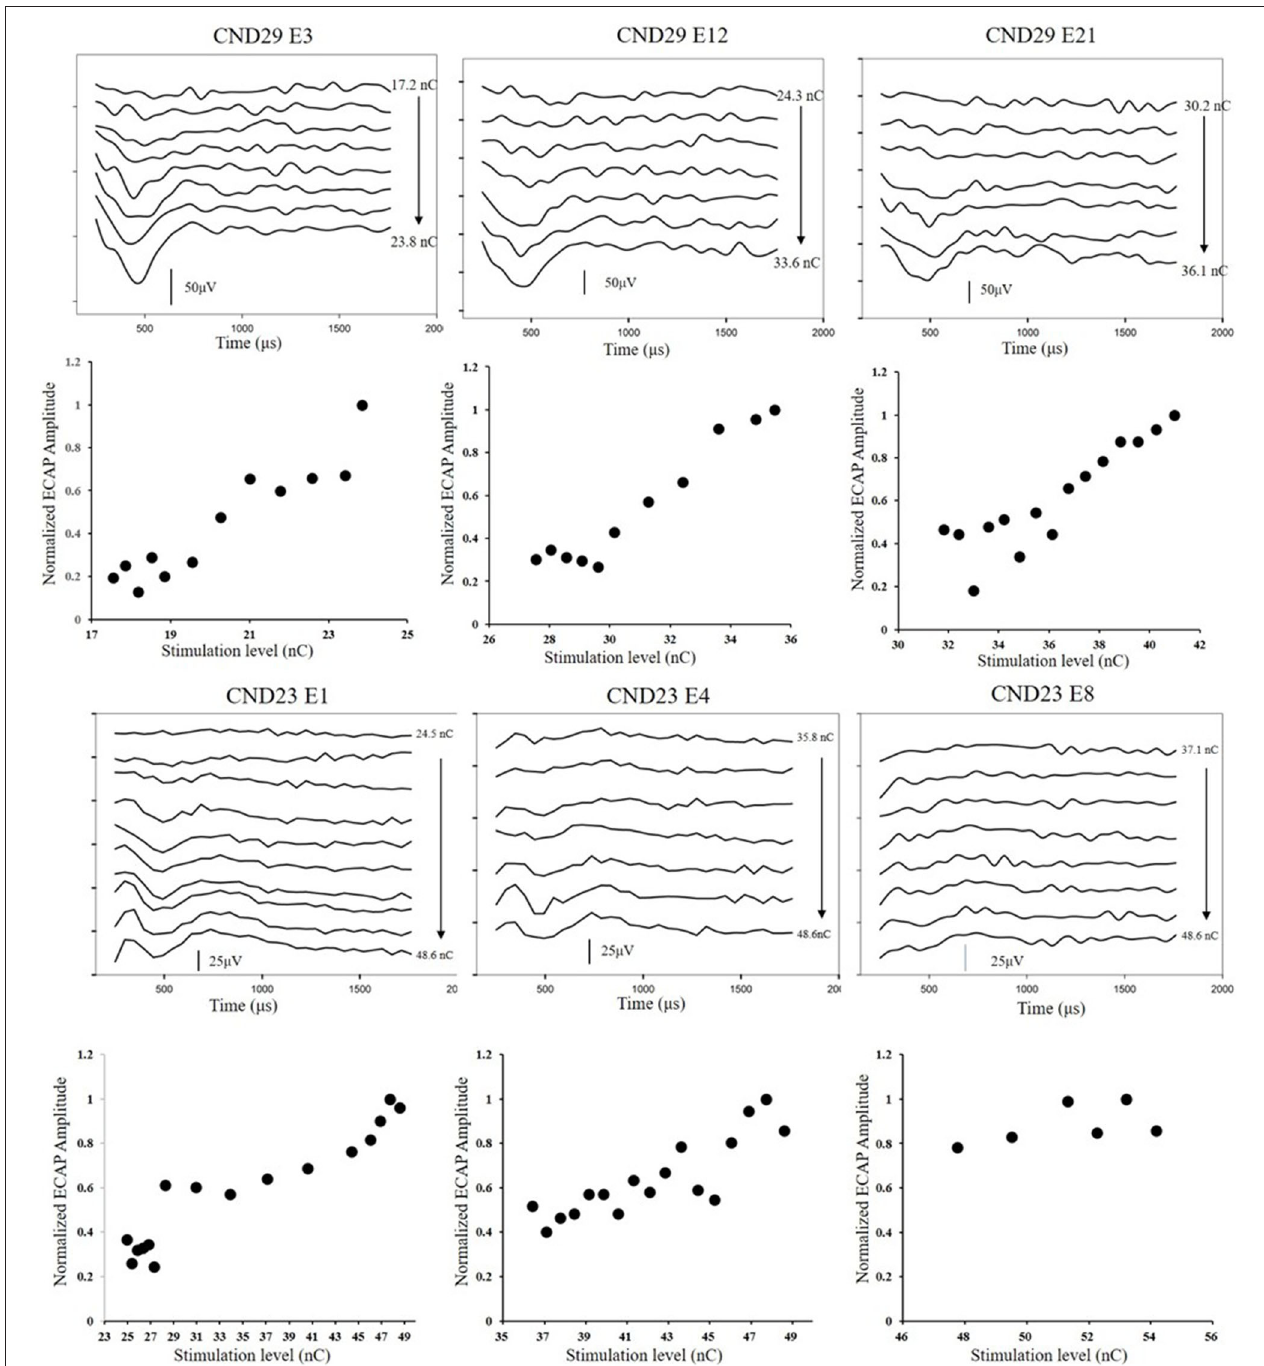
FIGURE 3 | ECAP response traces and ECAP I/O functions measured at three electrode locations in CND29 (upper) and CND23 (lower). Participants and electrode numbers are displayed in each panel. The round dots represent normalized ECAP amplitudes measured at different stimulation levels. E, electrode; ECAP, electrically evoked compound action potential; CND, cochlear nerve deficiency; I/O, input/output.